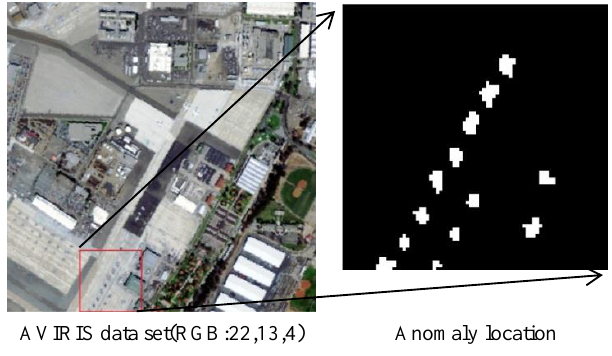
Fig. 4 The San Diego airport hyperspectral data with its test region and the target map